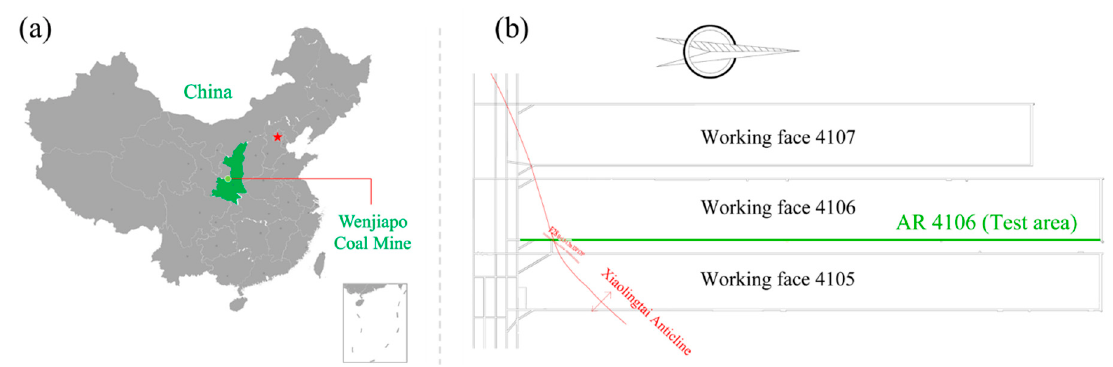
Figure 1. Location of Wenjiapo Coal Mine and layout of experimental roadways: ( a ) location of Wenjiapo Coal Mine; ( b ) layout of experimental roadway.